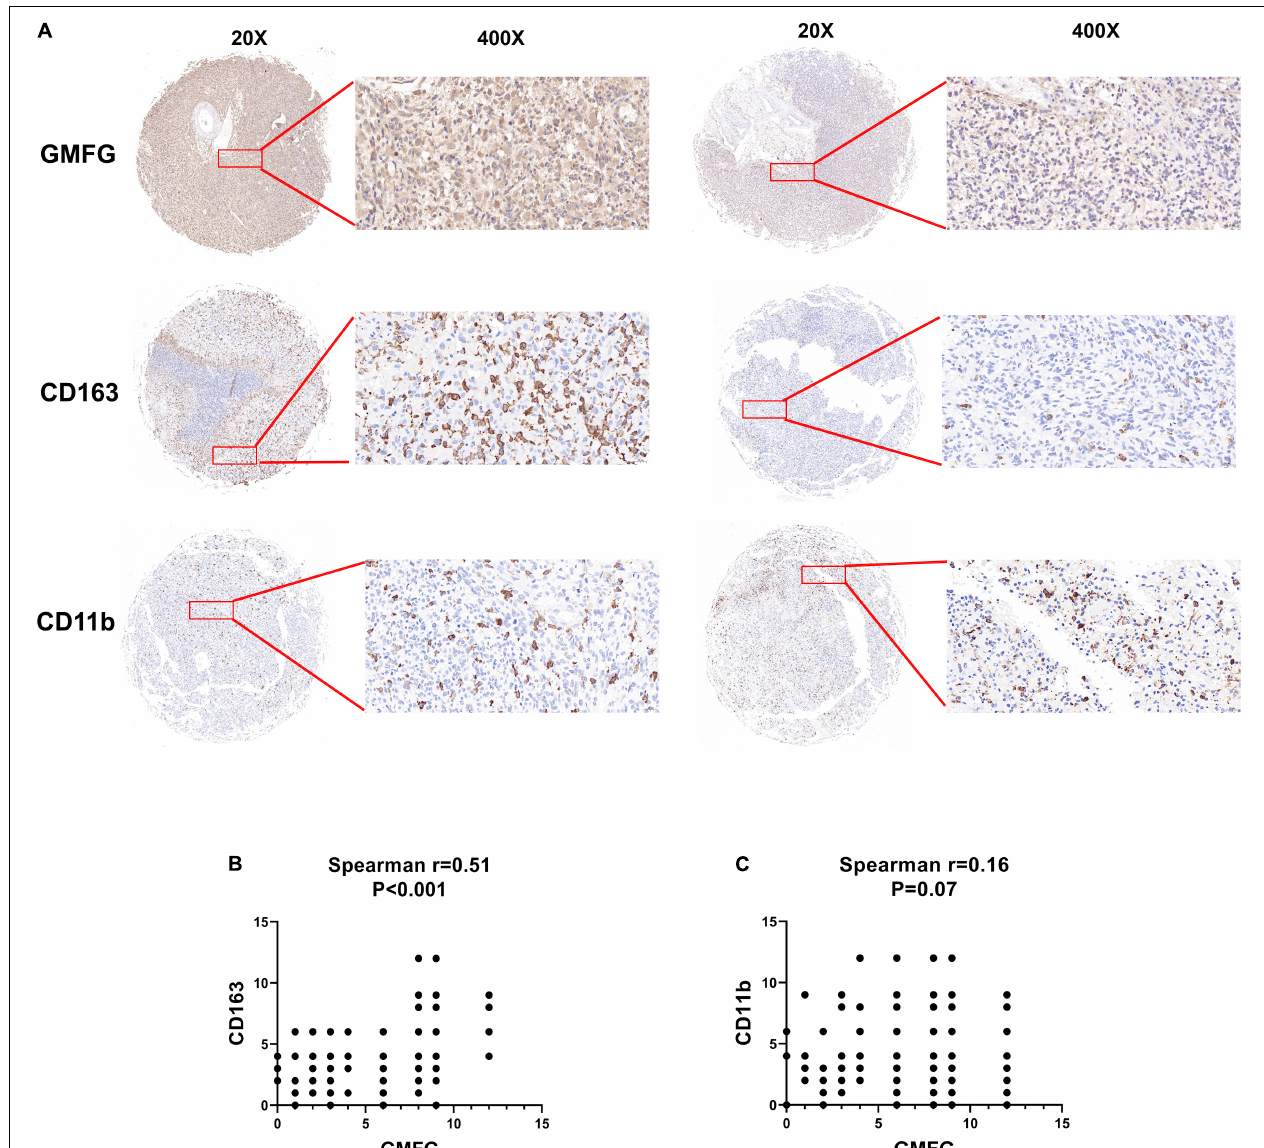
FIGURE 6 | Association between GMFG expression and tumor-associated macrophages infiltration in gliomas. (A) We detected immune cells (CD11b + and CD163 + ) infiltration in GBM and LGG samples using IHC staining, respectively. (B,C) Spearman correlation was employed to explore correlation between immune cells infiltration and GMFG expression. The IHC staining results were independently analyzed by two individuals.